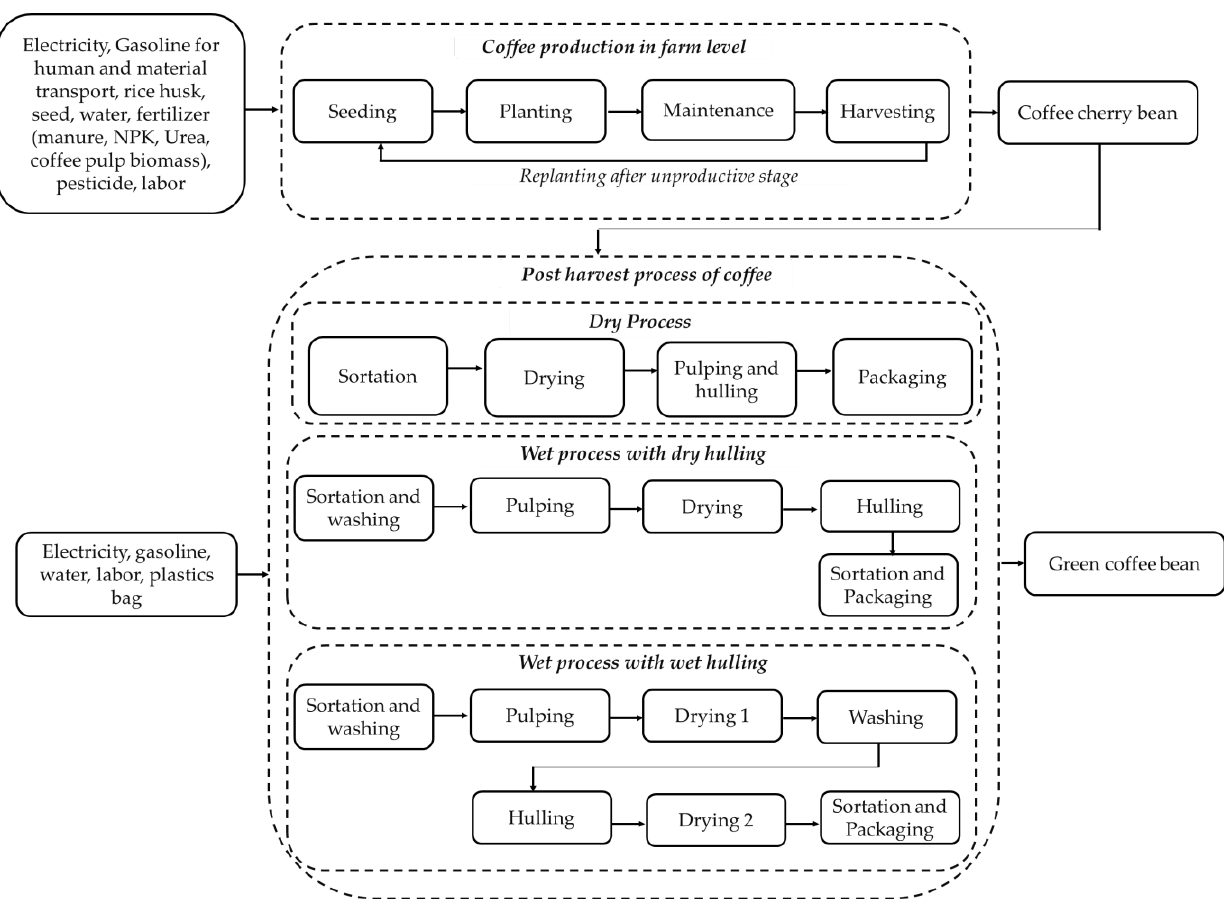
Figure 4. The boundary system for this study.